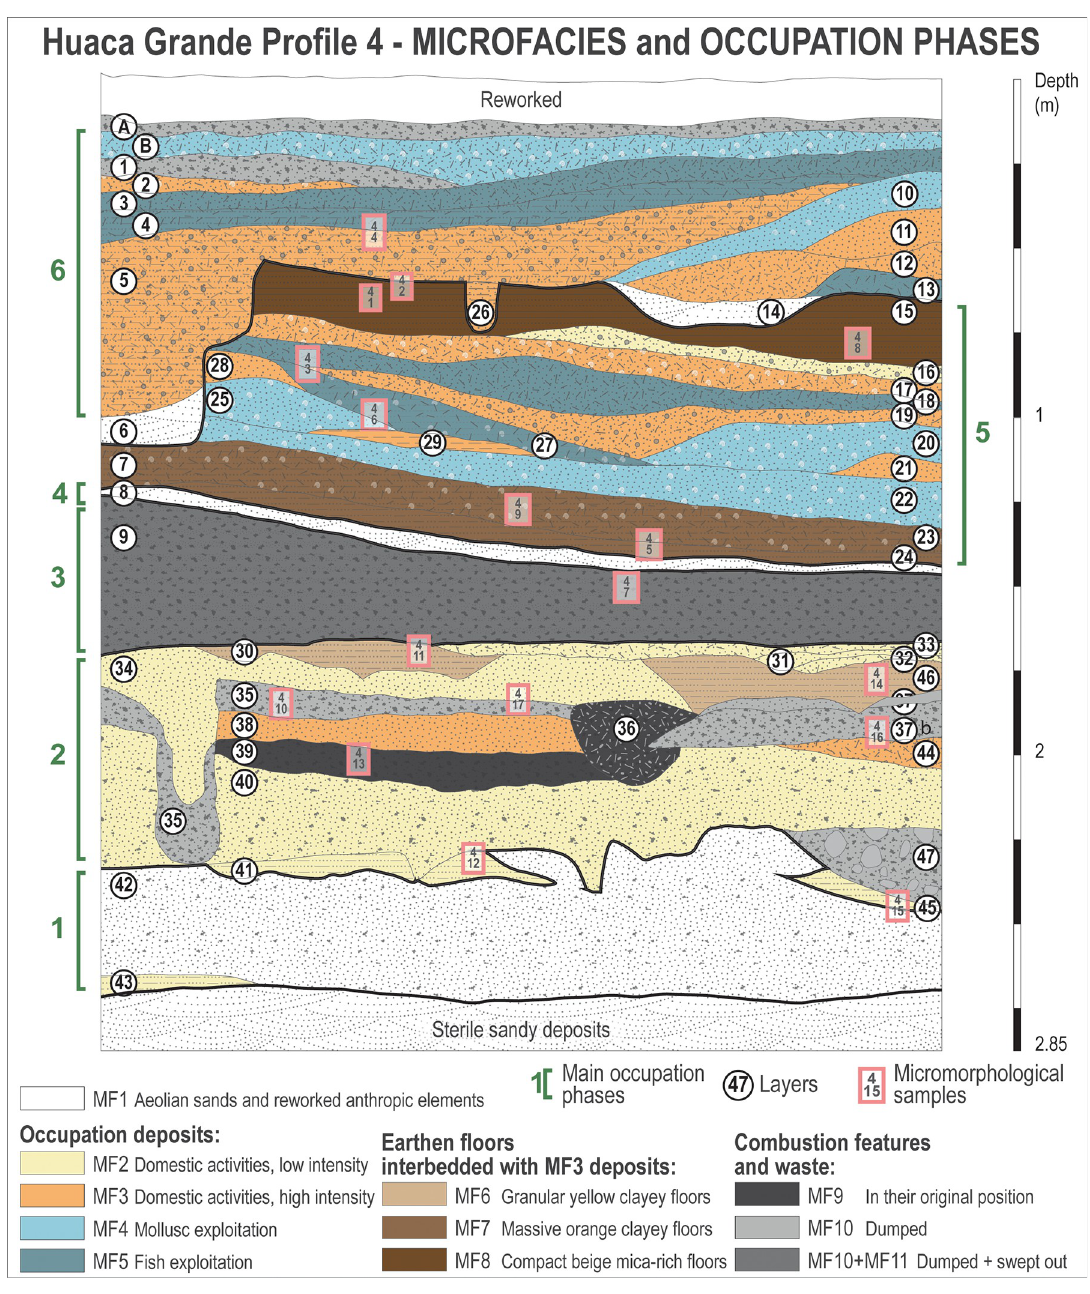
Fig 13. Microfacies and occupation phases distinguished along the Huaca Grande archaeological